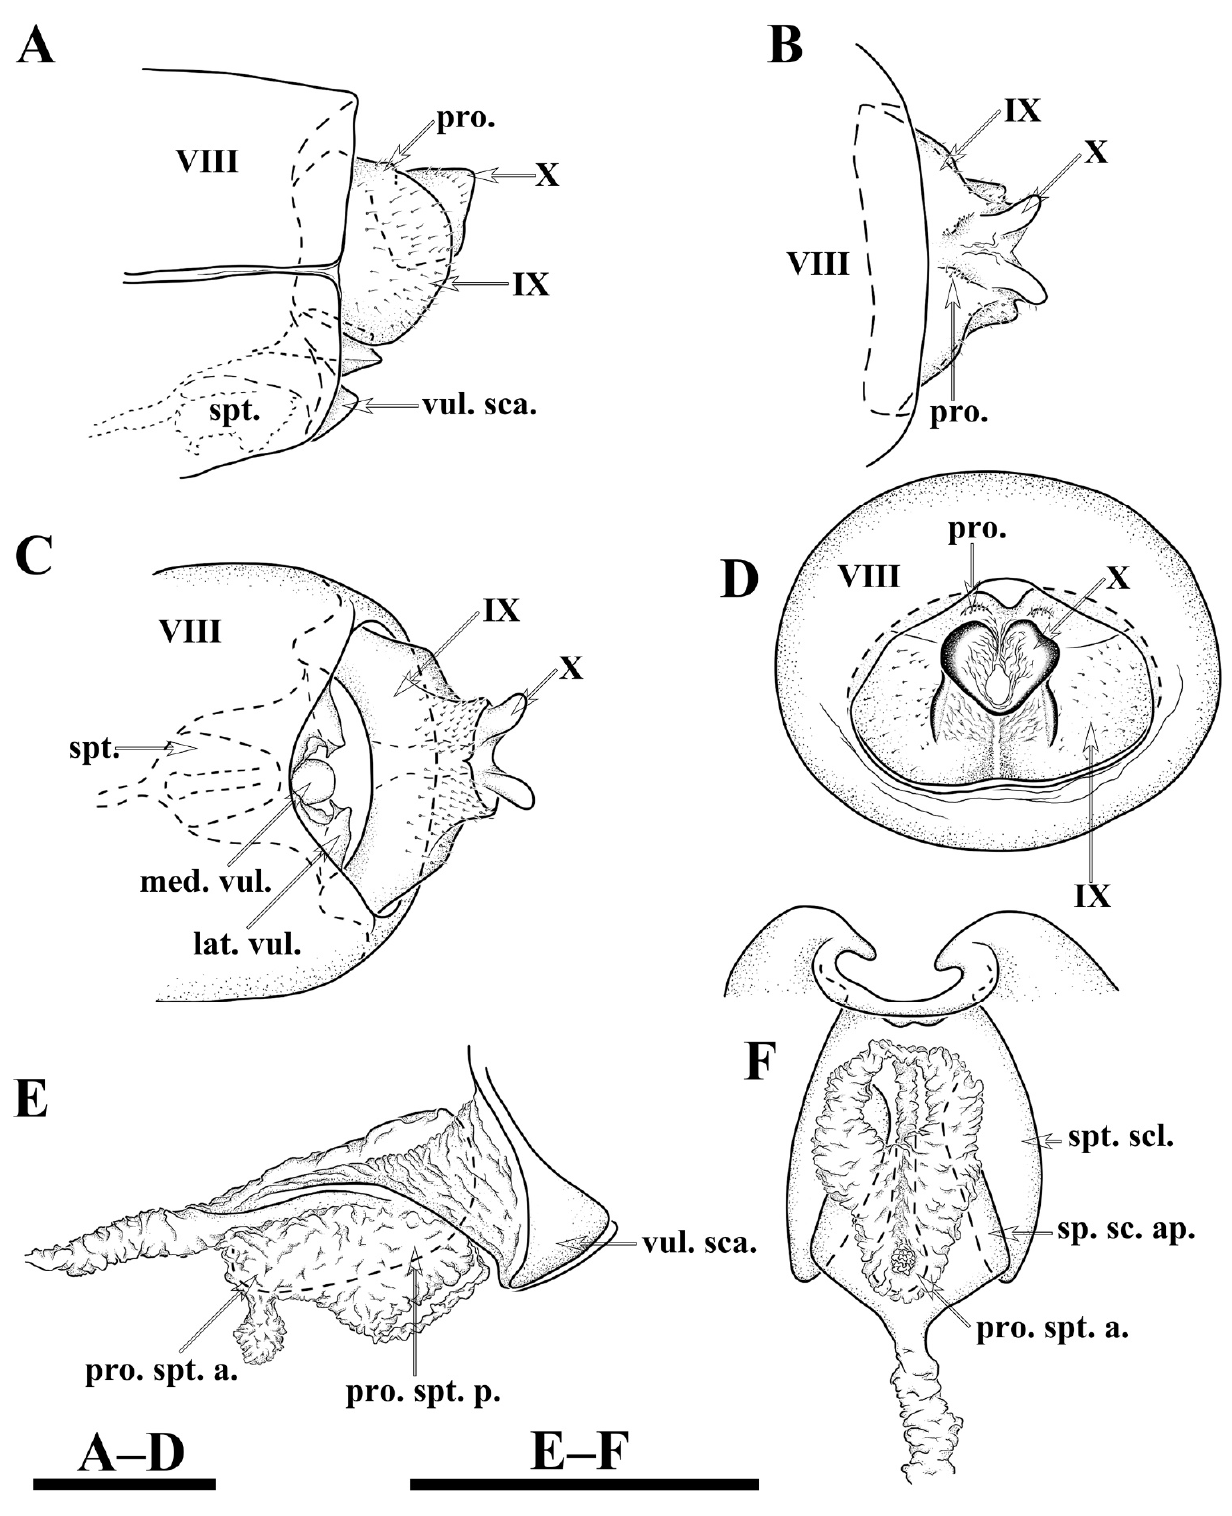
Figure 6. Limnephilus deqianensis n. sp. , line drawing of female genitalia. ( A ) Left lateral; ( B ) dorsal; ( C ) ventral; ( D ) caudal; ( E ) spermatheca, left lateral; ( F ) spermatheca, ventral. Abbreviations: lat. vul. = lateral vulvar lobe (paired); med. vul. = median vulvar lobe; pro. = processus; pro. spt. = processus spermatheca; pro. spt. a. = anterior section of processus spermatheca; pro. spt. p. = posterior section of processus spermatheca; sp. sc. ap. = spermathecal sclerite apodeme. Scale bars: 1 mm.